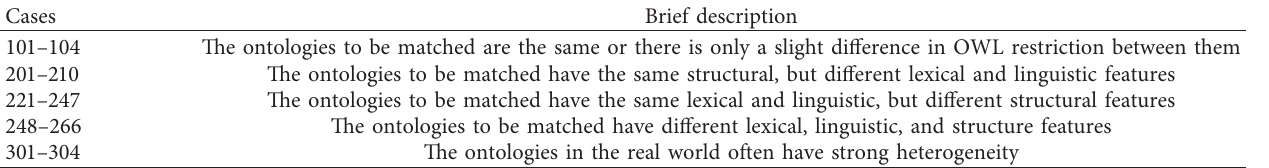
Figure 7: An example of linkage learning. Table 3: A brief description of OAEI Biblio